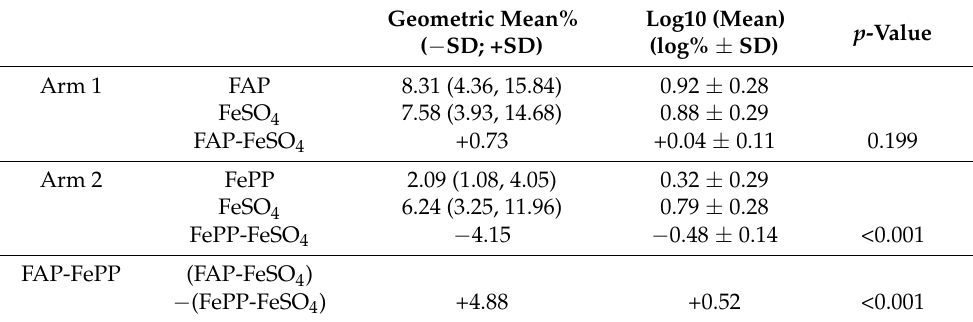
Table 2. Iron absorption in children, descriptive statistics (Geometric mean % − 1SD; +1SD, and log10 (Mean ± SD)) per treatment, and comparison in each study arm, as well as the estimated effect between the study arms.